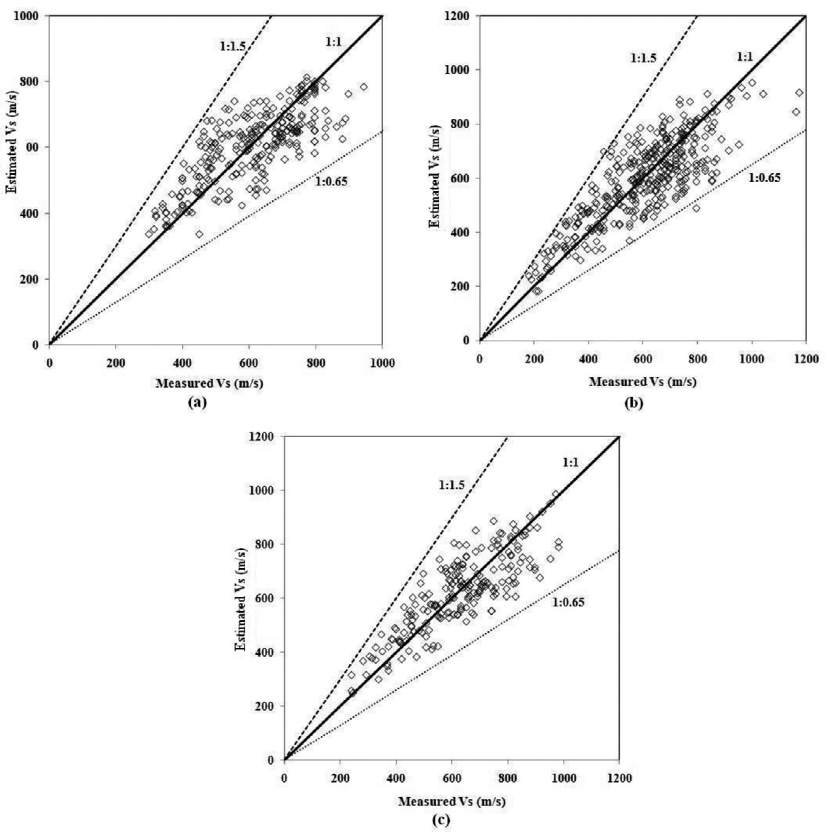
for (a) fine grain soil, (b) sandy soils and (c) gravely soils with lines of 1:1.5, 1:1 and 1:0.65. Figure 8. Measured versus estimated V s